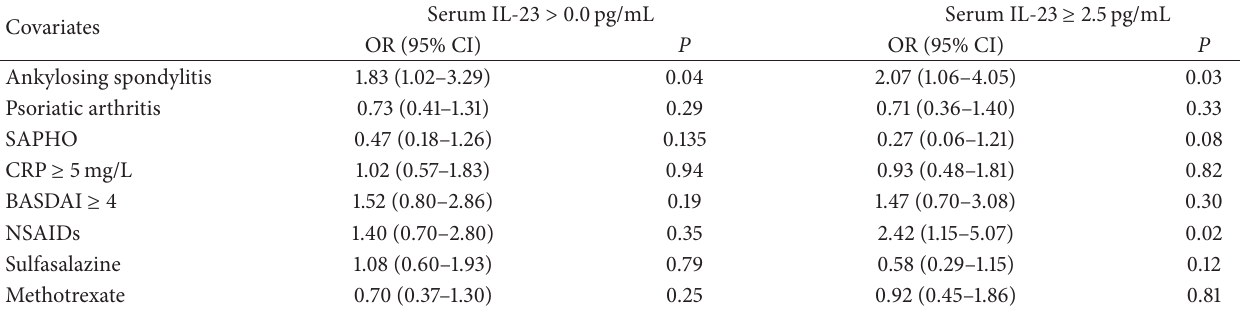
Table 3: A logistic regression model of the OR of the increased serum level of interleukin-23 in spondyloarthritis patients. Serum IL-23 > 0.0 Covariates